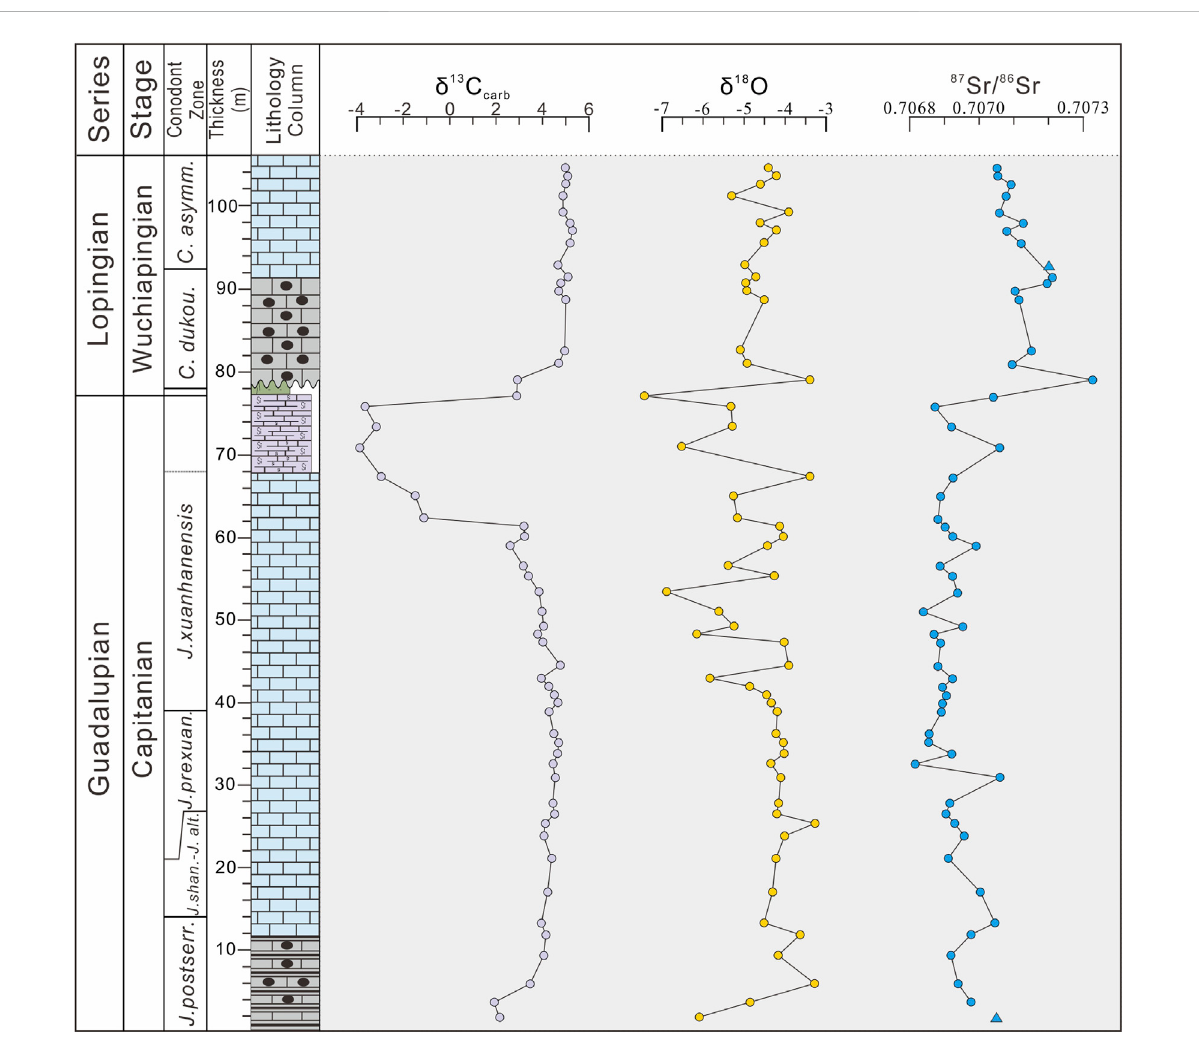
FIGURE 4 The pro fi les of carbon, oxygen and strontium isotopes of the Dukou section (The legend is shown in Figure 1D, the triangles are samples that may be affected by diagenesis) (The data of δ 13 C carb discussed here was published with no detail discussion in our previous paper, the lower 36 data points of Sr isotopes was published in our previous